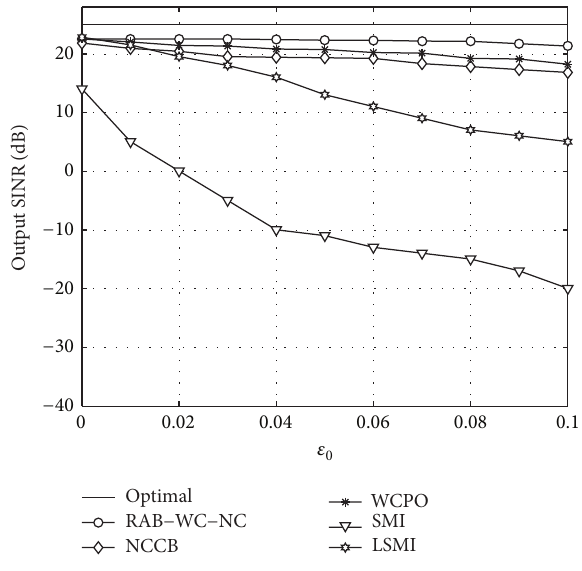
Figure 4: Output SINR versus 𝜀 0 .